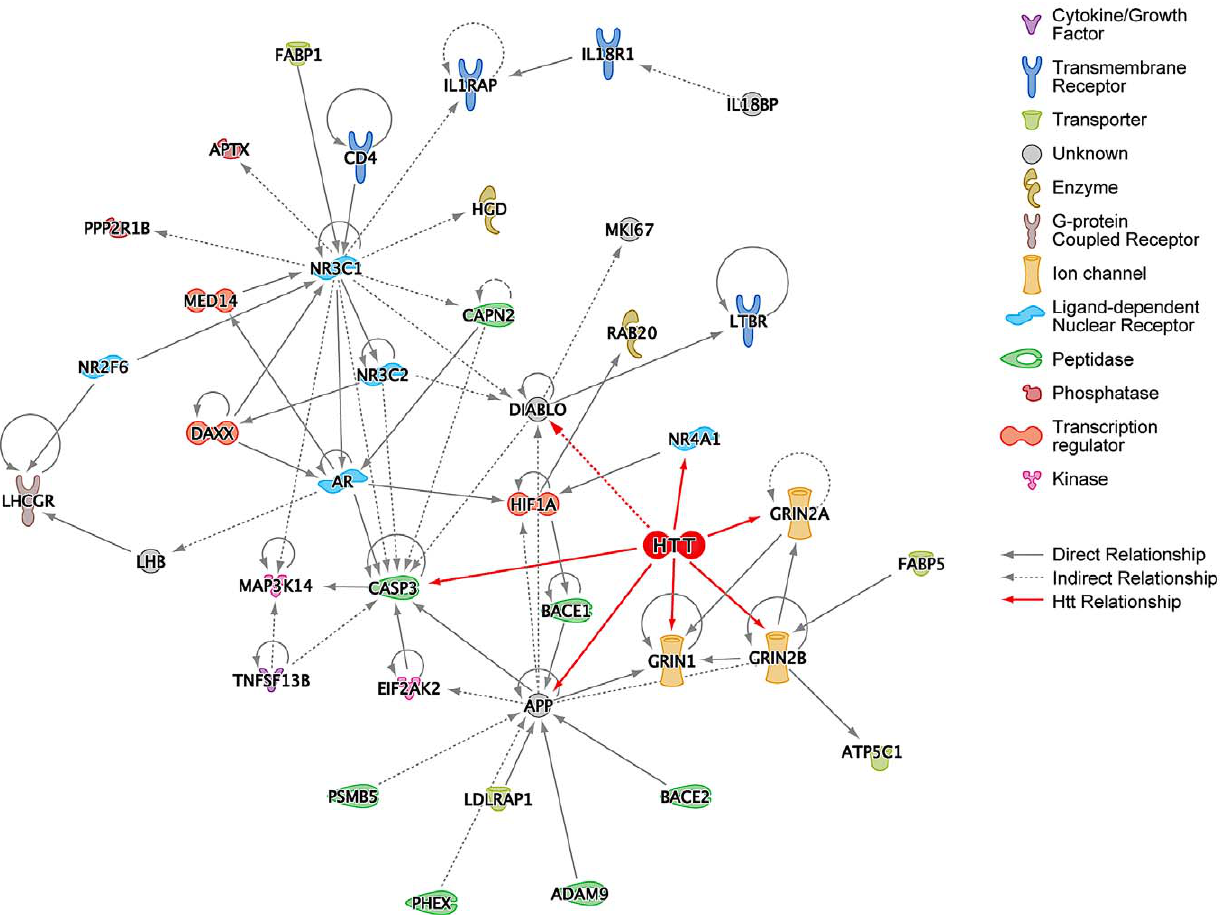
Figure 2. Ingenuity Pathway Analysis (IPA) of HD Suppressor Genes. (A) IPA network of the HD suppressor genes that could be directly connected to each other without intervening nodes. This network was constructed using data from all Ingenuity model organisms. Huntingtin (HTT) was manually added to this network, and its connections colored red. Functions of nodes are indicated with icons. ‘‘Direct Relationship’’ (solid lines) indicates direct physical contact between two molecules, e.g. binding or phosphorylation. ‘‘Indirect Relationship’’ (dotted lines) indicates a functional interaction that does not require physical contact between the two molecules, e.g. signaling events. See also Figure S3.